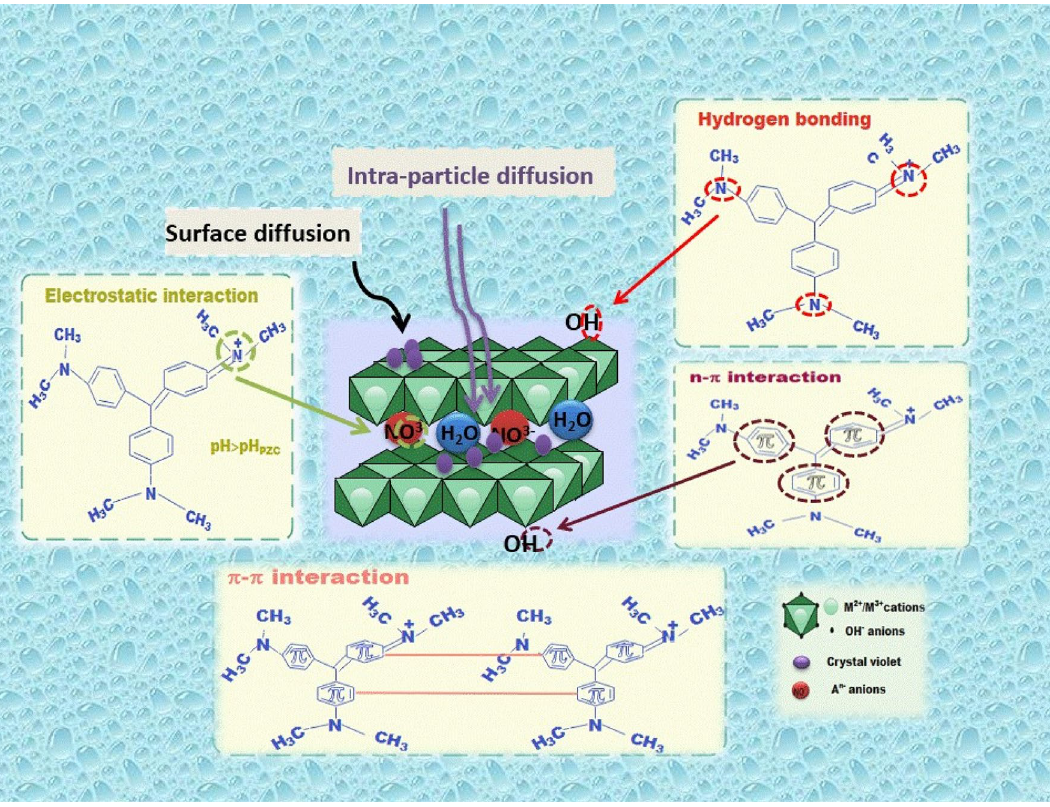
Figure 9. Possible adsorption mechanism of